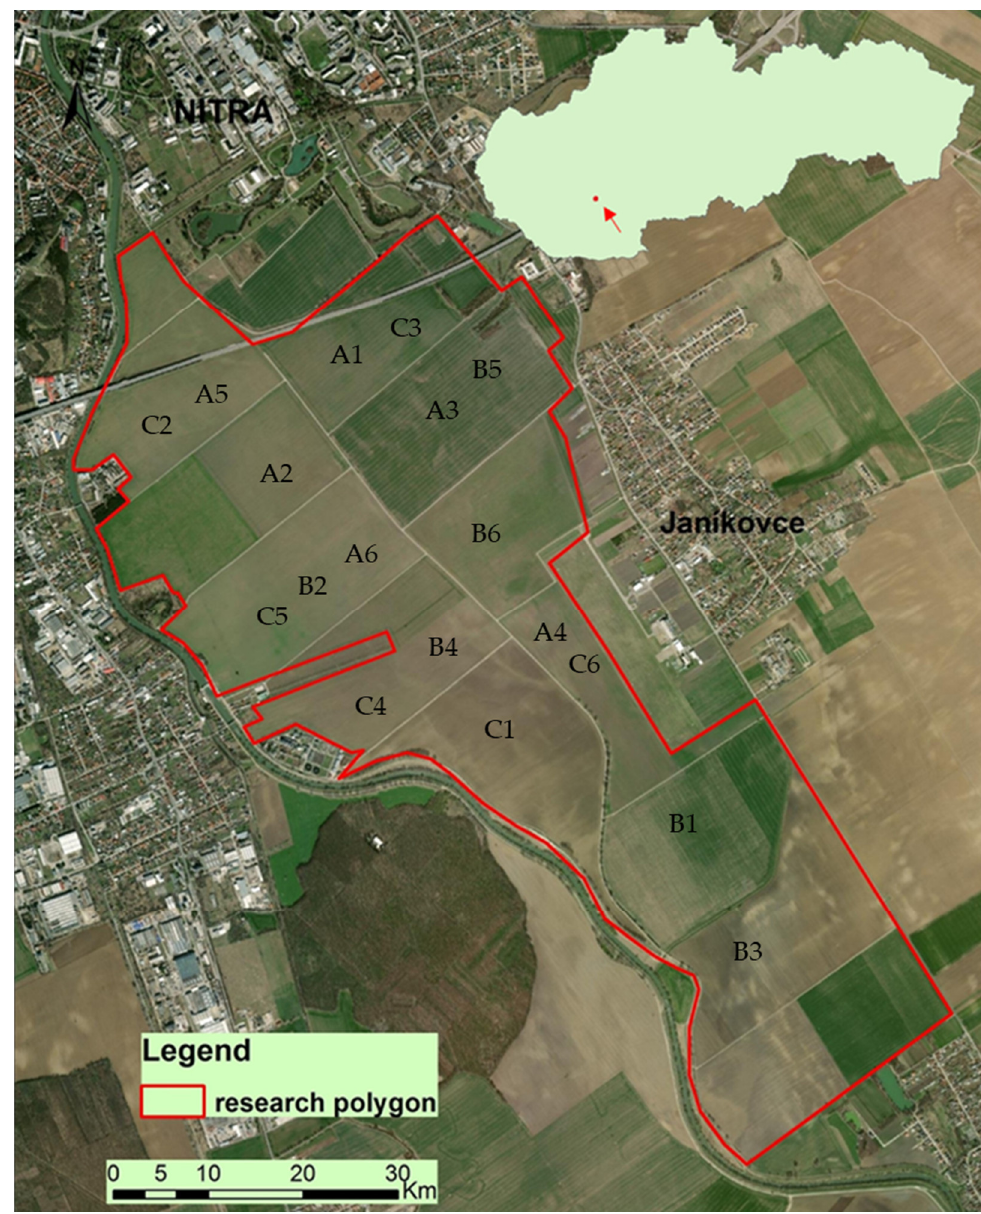
Figure 1. Map of the study area. Years: (A) 2018, (B) 2019, (C) 2020. Crops: (1) Brassica napus , (2) Pisum sativum , (3) Zea mays , (4) Grass mixture, (5) Triticum aestivum , (6) Triticum spelta.